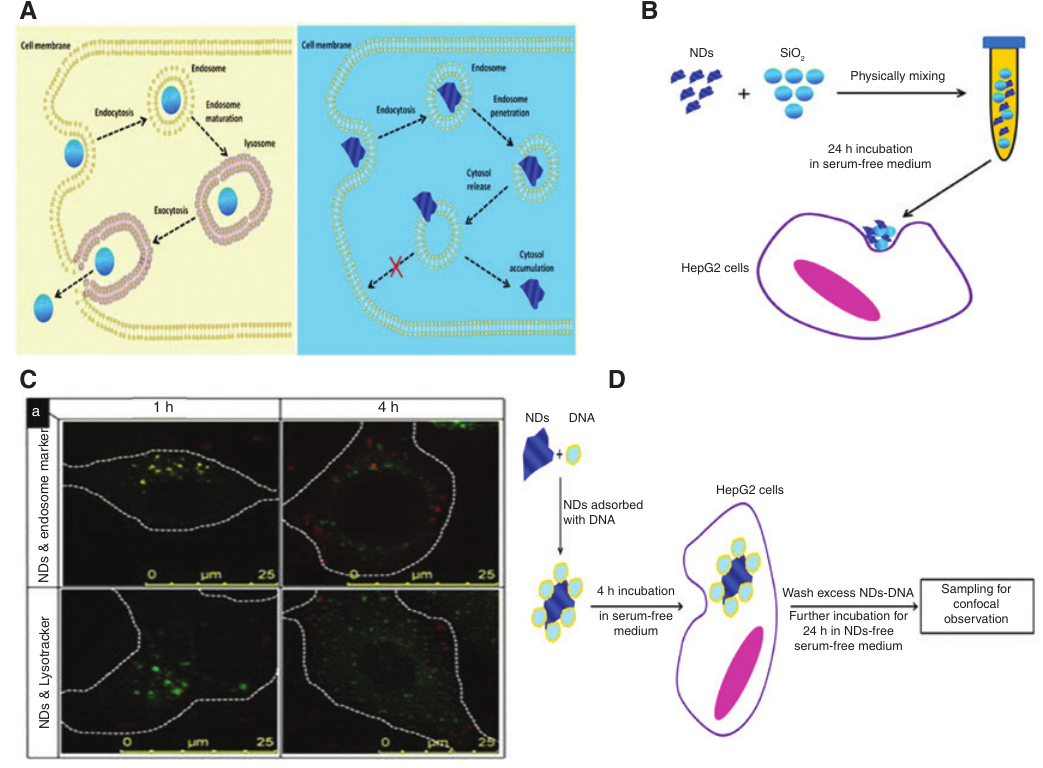
Figure 9: An illustration of rough nanodiamonds effects in living cells. (A) An illustration showing nanoparticle (NPs) with low sharpness and sharp corners entering the cell. Left, round NPs enter cells via endocytosis with the endosome as the vehicle and finally exit the cell. Right: a sharp-shaped nanoparticle enters the cell via endocytosis with the endosome as the vehicle and escapes the endosome by rupturing the endosomal membrane and staying in the cytoplasm for a long time. Adapted from [113]. (B) A schematic demonstration of how nanodiamonds escape the endosomal membrane. (C) Confocal images of efficient nanodiamonds delivery into HepG2 cells after cell incubation with nanodiamonds in serum-free medium for 1 or 4 h. (D) A schematic illustration of nanodiamonds as a successful carrier for gene (DNA) in cells. Adapted from